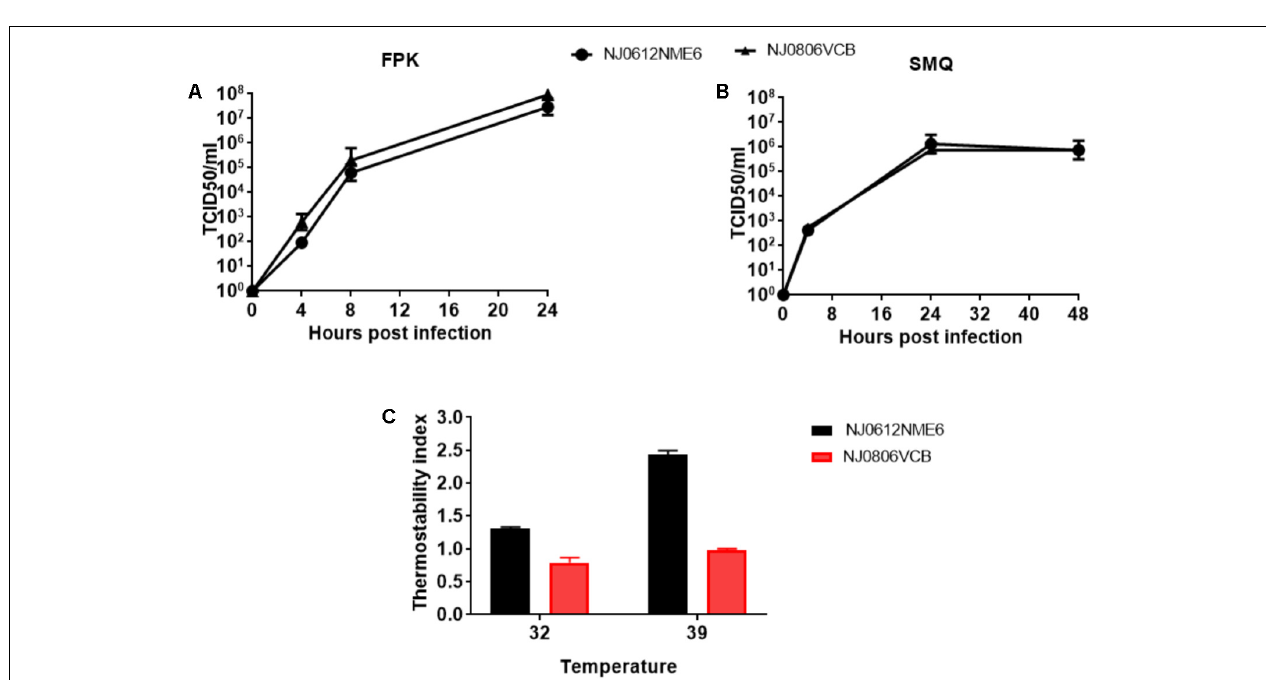
FIGURE 4 | In vitro growth characteristics of NJ0612NME6 and NJ0806VCB. (A) Fetal porcine kidney cells and (B) porcine macrophage cells were infected at an MOI = 0.01 and virus yields obtained at the indicated times post-infection were titrated in Vero cells. Data represents the means and standard deviations from three independent experiments. (C) The ability of NJ0612NME6 and NJ0806VCB to grow at 32 ◦ C and 39 ◦ C. Thermostability index was determined by the viral titer of each strain at the specific temperature divided by the titer at 37 ◦ C. Values > 1 reflect higher thermostability, < 1 lower thermostability and =1 no changes in